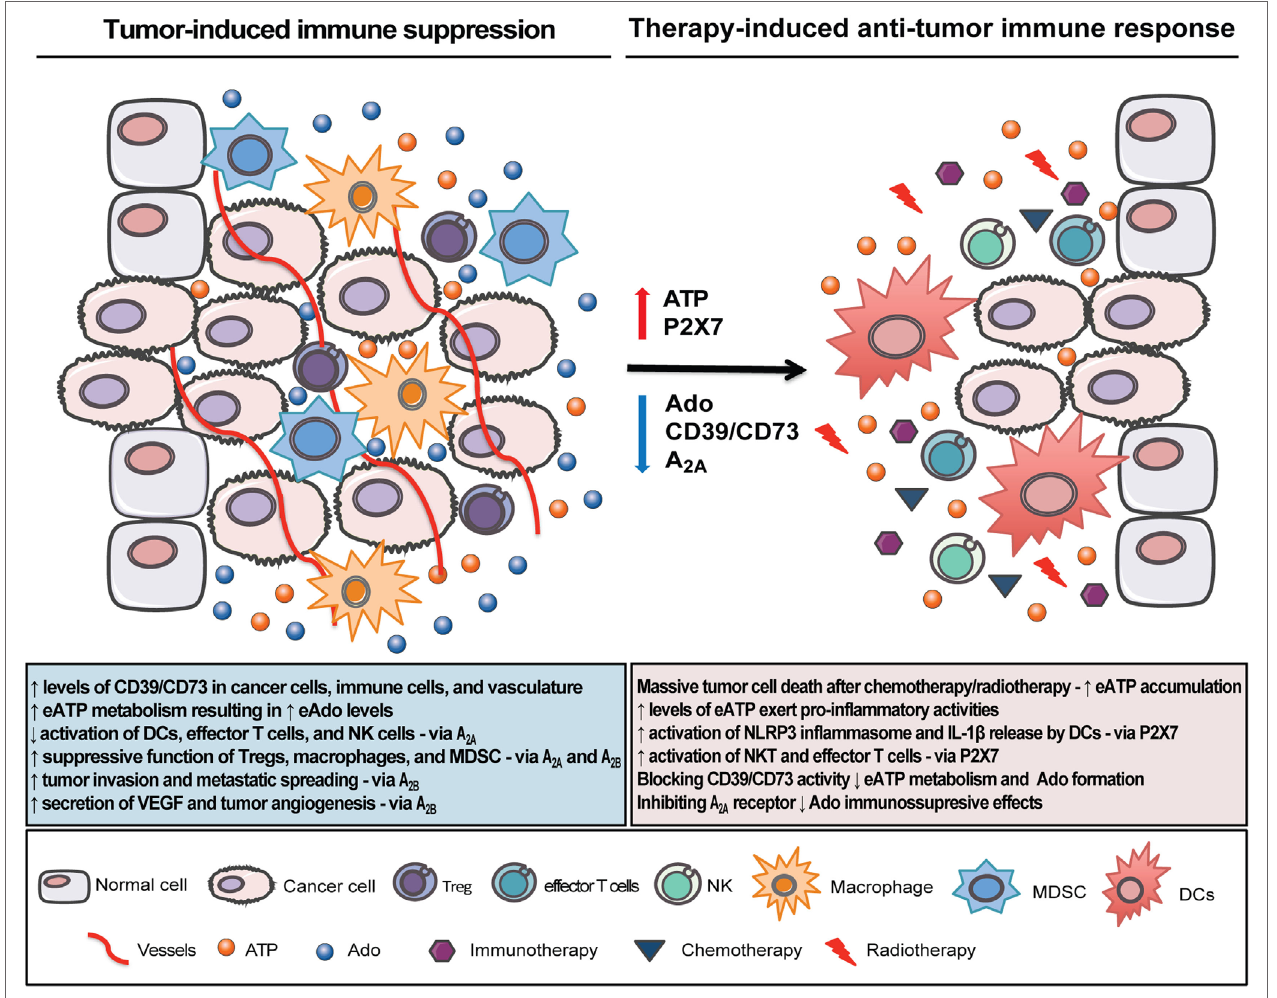
FigURe 3 | Therapeutic strategies to overcome tumor immune escape and boost cancer immunosurveillance in the tumor microenvironment (TME). In the inflammatory TME, tumor and immune cells interact to produce a favorable immunosuppressive microenvironment. Extracellular adenosine triphosphate (eATP), a pro-inflammatory mediator, accumulates in the TME, but it is rapidly converted to the immunosuppressive factor adenosine (Ado) via the sequential enzymatic activity of CD39 and CD73. Ado acting through A 2A and A 2B receptors inhibits dendritic cells (DCs), NK, and effector T cells activation while it enhances the suppressive function of Tregs, macrophages, and myeloid-derived suppressor cell (MDSC). Strategies by targeting Ado formation, i.e., by blocking CD39/CD73 enzymes and Ado receptors (mainly A 2A ) will build up eATP concentration and improve the antitumor immune response. Specifically on DCs, eATP acting through P2X7 receptor will trigger NLRP3 inflammasome activation and IL-1 β release with consequent stimulation of CD8 + and CD4 + lymphocyte-mediated antitumor response, which is a critical step for the efficacy of chemotherapy and radiotherapy. Therefore, combining purinergic-targeting therapies with other anticancer modalities may be a new strategy to overcome immune escape, potentiate antitumor immune response, and consequently restrain tumor